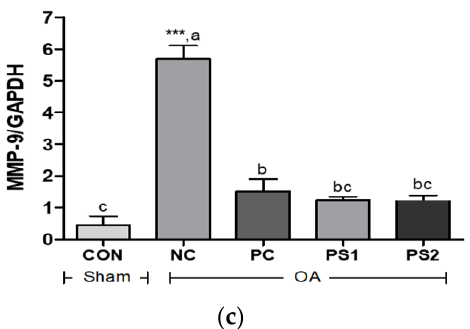
Figure 7. Effects of PS on cytokines expression in the cartilage with synovial membrane of OA rats. ( a ) MMP-2, ( b ) MMP-3, and ( c ) MMP-9. Data are expressed as the mean ± SE (n = 4/group). CON: normal sham control; NC: negative control; PC: positive control; PS1: PS at 100 mg/kg BW; PS2: PS at 300 mg/kg BW. NC group was significantly different from the CON group at *** p < 0.001 by Student’s t test. a – c Mean values with different letters are significantly different ( p < 0.05) among groups by Duncan’s multiple range test.